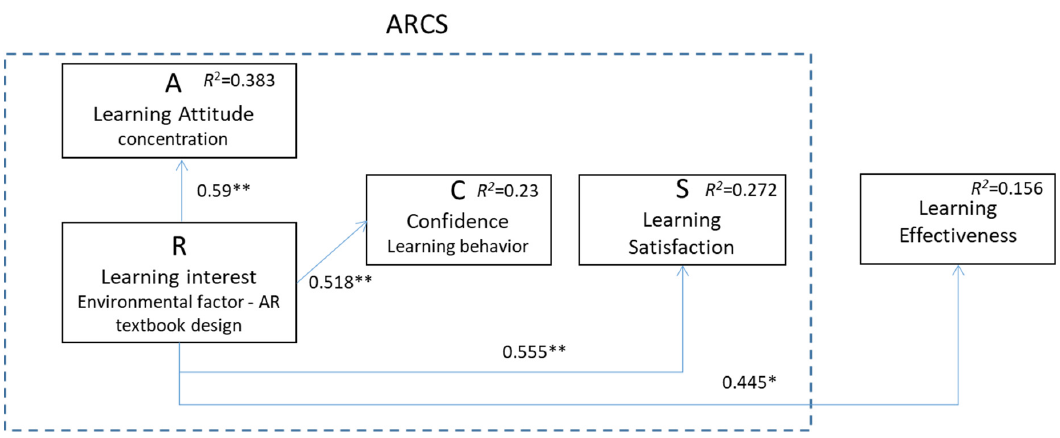
Figure 8. ARCS model path analysis results of test group learning performance. * p < 0.05, ** p < 0.01